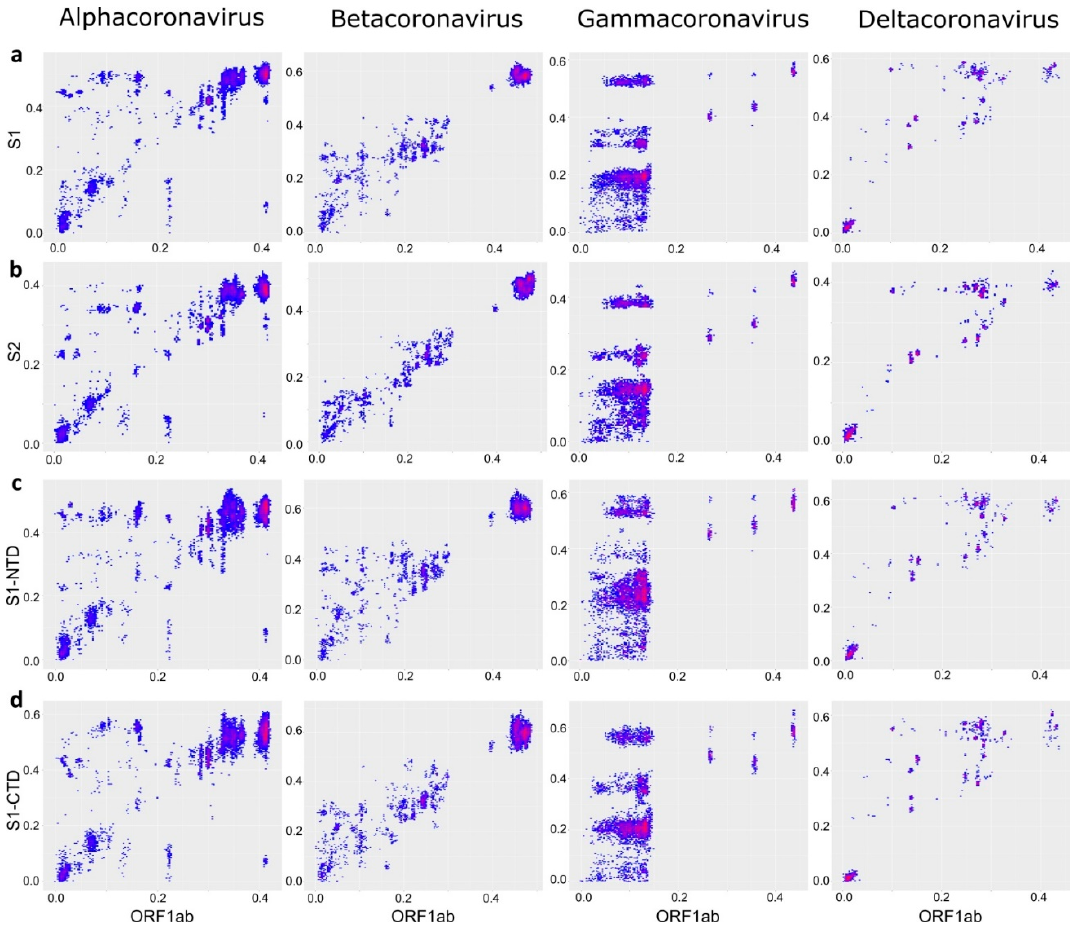
Figure 7. S1-NTD is the most mobile part of spike relative to the rest of the genome in β -CoV, while in the other genera spike is exchanged as a whole. Correspondence of pairwise nucleotide distances between ORF1ab and different regions of the spike protein: S1 ( a ), S2 ( b ), S1-NTD ( c ), S1-CTD ( d ).